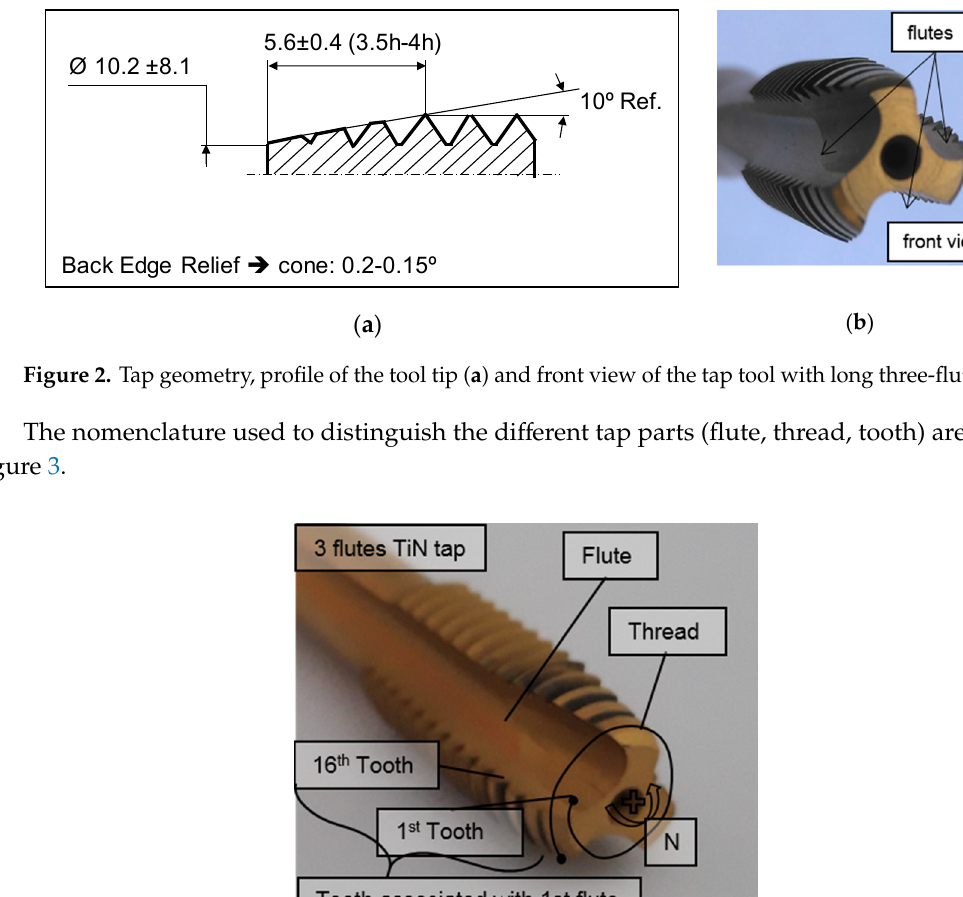
Figure 1. Mounting of the plate set-up for tapping experiments.